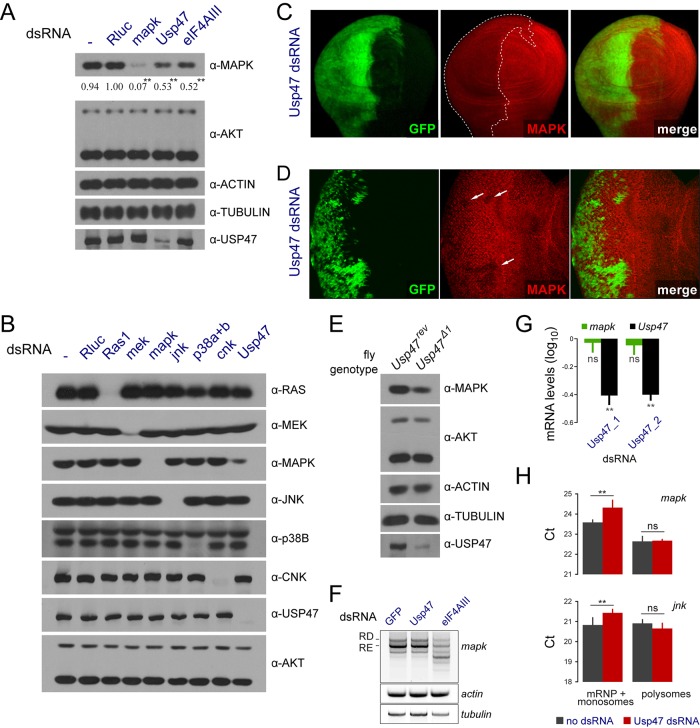
Usp47 regulates MAPK levels.(A) Usp47 depletion causes a reduction in MAPK levels probed by immunoblot. S2 cells were treated with the indicated dsRNAs. The EJC component eIF4AIII was used as a control for a factor that reduces MAPK expression [7]. ACT5C (FBgn0000042), α-TUBULIN (FBgn0003884), and AKT (FBgn0010379) levels (loading controls) were not impacted by Usp47 depletion. Densitometry quantifications are provided for MAPK levels normalized to the AKT loading controls (similar quantification results are obtained by using either the ACTIN or the TUBULIN controls for normalization (see S1 Data). Two AKT isoforms (short and long) are detected in S2 cells by western blot. We exclusively used the shorter variant as loading control for quantification purpose, as its levels are in the same detection range as MAPK from the same sample lysate. The levels of the long AKT isoform were slightly variable across experiments and thus were not used for quantification. Their experimental variation was likely caused by their lower abundance, which in turn would produce signals outside the linear range of the film. This experiment was performed in seven replicates, and p-values were calculated (paired two tailed Student’s t test) comparing values to the Rluc control (*: p < 0.05; **: p < 0.01). (B) Usp47 depletion did not alter the levels of other RAS-MAPK pathway components (RAS, MEK, and CNK), nor of two other MAPK family kinases (JNK and p38). As AKT, ACTIN, and TUBULIN were found to be interchangeable loading controls in experiments that address the impact of USP47 on MAPK levels (A), we decided for convenience to monitor only AKT levels as loading control here and in most subsequent experiments. AKT was selected over ACTIN or TUBULIN because its transcript levels, according to modENCODE, are similar to those of mapk (unlike for actin or tubulin, which are 200–500-fold more highly expressed), and thus allowed the comparison of similarly expressed genes. Importantly, AKT levels are not known to be modulated by MAPK signaling. For instance, we never observed variations in AKT levels following perturbations in RAS-MAPK signaling [7,8], which is also reflected here in (B). Finally, the other monitored proteins in (B) also serve as points of comparison to infer that AKT levels are not impacted by Usp47 depletion. (C-D) MAPK levels are also reduced by Usp47 knockdown in vivo. Tissue expressing Usp47 RNAi (using the VDRC RNAi line: GD26027) is marked with GFP. (C) The expression of Usp47 RNAi was induced using an engrailed-Gal4 promoter that drives expression in the posterior segment of wing discs. (D) Heat shock-induced flip-out clones expressing Usp47 RNAi in eye imaginal discs also show reduced MAPK levels. (E) MAPK protein levels are reduced in flies bearing the Usp47Δ1 mutation. Lysates were prepared from adult flies homozygous for either the hypomorphic Usp47Δ1 allele or a Usp47rev control (a WT Usp47 line generated by a precise excision of the P element used to generate the Usp47Δ1 allele). (F-G) Usp47 depletion does not impact the mapk transcript levels. (F) mapk transcript levels were measured following dsRNA treatment using an RT-PCR assay targeting the 5′ and 3′ UTRs that amplifies the RD and RE splice isoforms of mapk. eIF4AIII (FBgn0037573) dsRNA is used as a control that alters mapk splicing. Act5C and γ-Tubulin (γTub23C; FBgn0260639) loading controls are also shown. (G) mapk transcript levels measured by qPCR (normalized to GFP dsRNA control) are not impacted by two different dsRNA reagents targeting Usp47 (p > 0.05) compared to an untreated control, while Usp47 levels are decreased in both cases (**: p < 0.01). “ns” denotes not significant. (H) Polysomal loading of mapk transcripts is not altered by Usp47 depletion. The polysome and messenger ribonucleoprotein (mRNP)/monosome fractions were separated on a sucrose gradient. qPCR was used to assay mapk and jnk mRNA transcript levels in both fractions. A slight decrease of mapk transcript abundance (**: p < 0.01) was observed in the mRNP/monosome fractions upon Usp47 depletion. However, this was observed for jnk transcripts and was not accompanied by a concomitant variation in the polysome fraction. “ns” denotes not significant. Raw data for (A, G, and H) can be found in S1 Data.